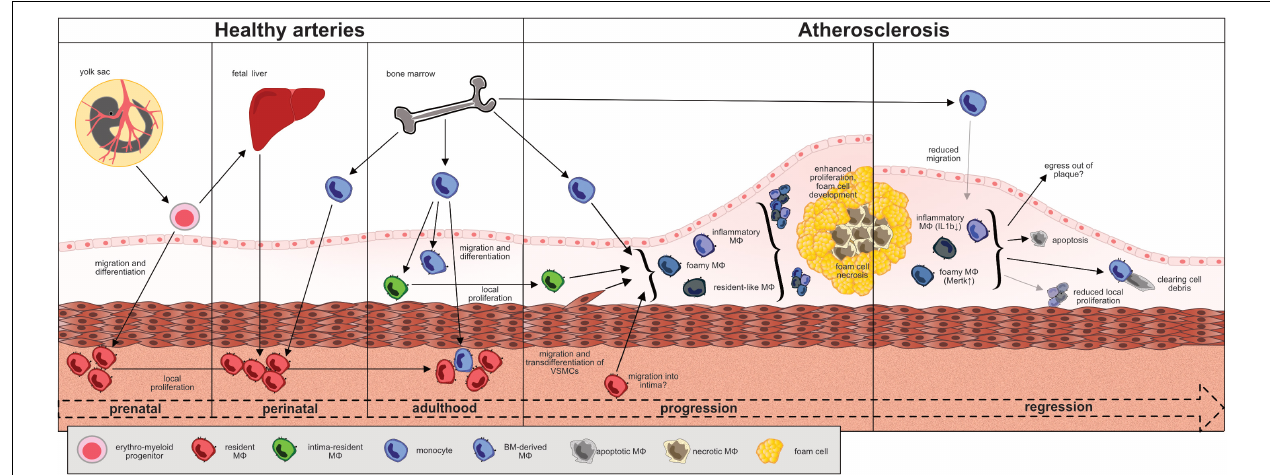
FIGURE 1 | Fate, trafficking and functional changes of macrophages during the “life cycle” of an atheromatous (murine) plaque. EMP-derived macrophages seed the tissues between day E9 and E12 of embryonic development. Macrophages reside primarily in the adventitia and sustain through local proliferation. Monocyte-derived macrophages from the fetal liver and, around birth, from the bone marrow seed the vessel wall and differentiate in the adventitia. The recently introduced intima resident macrophages (Mac AIR ) originate from the bone marrow and maintain through local proliferation. They are the first macrophages to get in contact with lipoproteins in the intima and are outnumbered and replaced by newly recruited monocyte-derived macrophages during atherogenesis. At advanced disease stages, local macrophage proliferation dominates cell turnover. Vascular smooth muscle cells may transdifferentiate and adapt a macrophage-like phenotype and contribute to the atheromatous foam cell population. The role of adventitial macrophages in this context remains to be elucidated. Major atheromatous plaque macrophage subpopulations, as defined by their transcriptomes, include resident ( Ccl8, Lyve-1, FOLR2, CXCL4 , F13a1, Wfdc17 ), inflammatory ( Cxcl2, Ccl2, Ccl3, Ccl4, Il-1b, TNF ), and TREM-2 + foamy ( Lgals3, Cd9, Ctsd ) macrophages. The degree of plasticity in between subpopulations and their respective roles in disease progression are under investigation. In murine models of atherosclerotic regression, inflammatory macrophages showed less Nlrp3 and IL1 β expression while Trem2 hi foamy macrophages expressed more Mertk and less Mmp2 in line with a rather atheroprotective function.